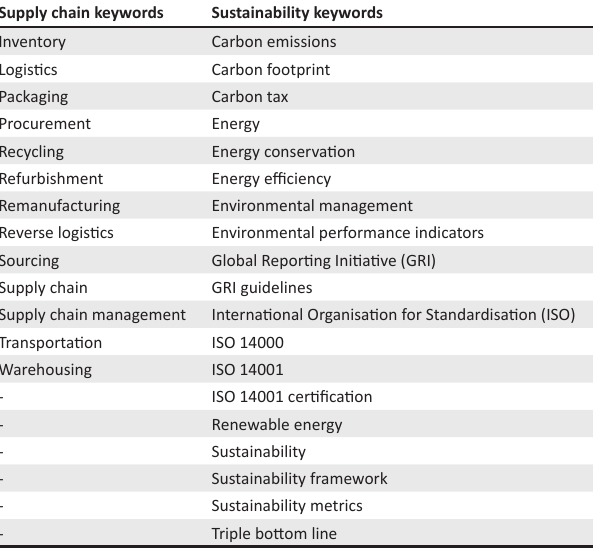
TABLE 1: Keywords relating to supply chain management and sustainability.